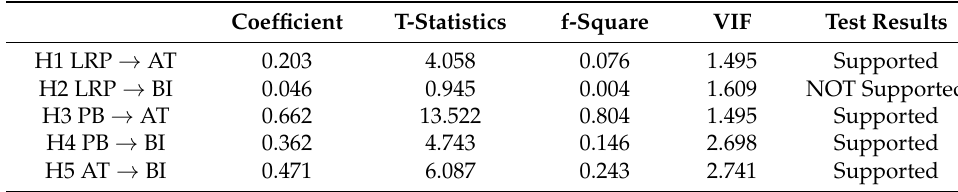
Figure 2. Results of PLS-SEM analysis. Table 6. Results of hypotheses